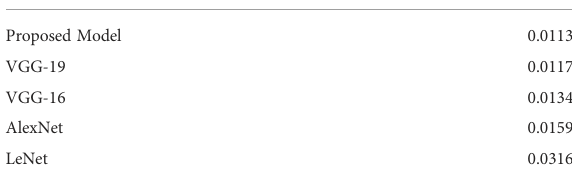
TABLE 8 Loss evaluation of different Models.